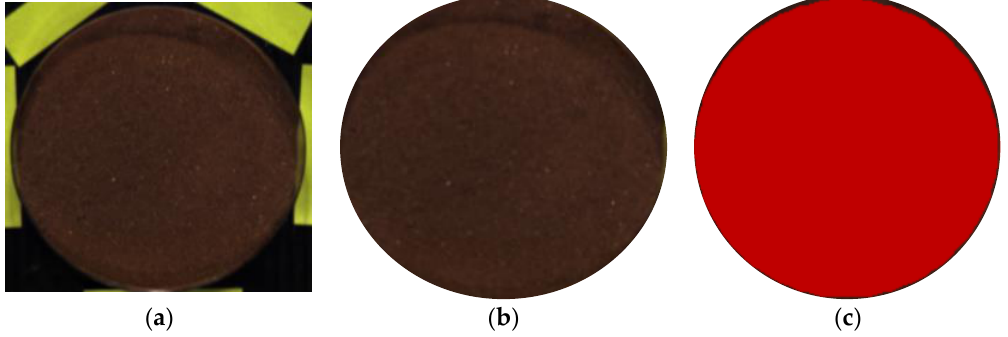
Figure 4. Soil image showing the “region of interest (ROI)” representing the average selected pixels: ( a ) hyperspectral image (specimen from Mt. Guryong), ( b ) remaining image, and ( c ) the region of interest in the granite soil.